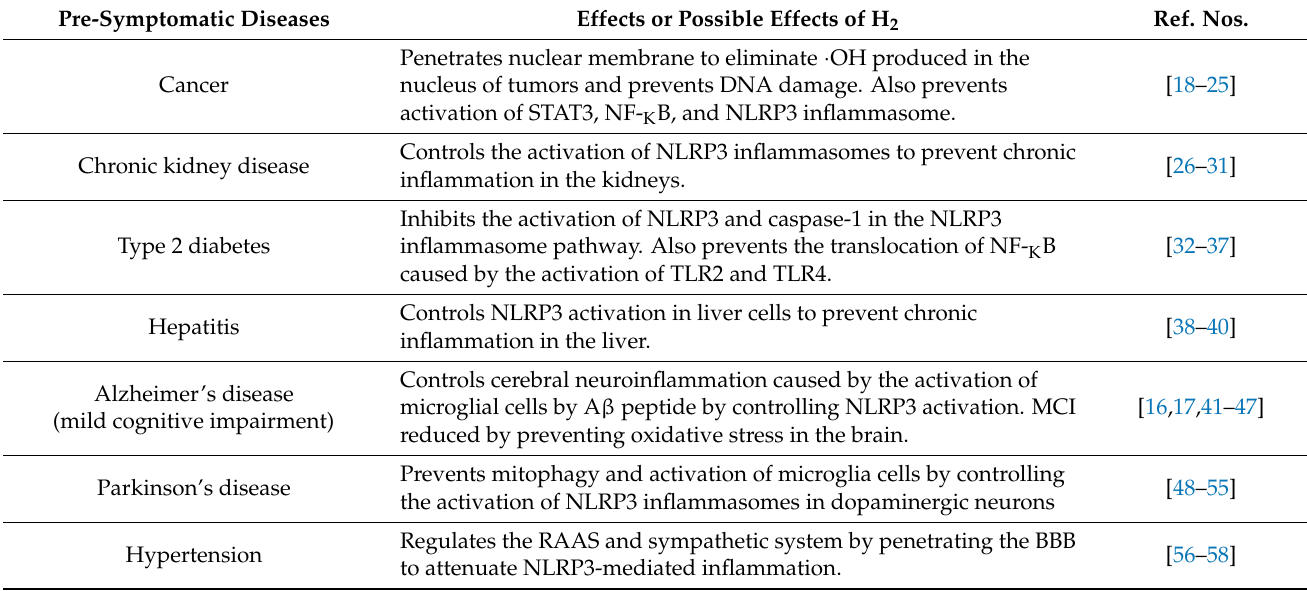
Table 1. Mechanisms of H 2 in preventing inflammatory diseases that arise from mibyou and chronic inflammation. Pre-Symptomatic Diseases Effects or Possible Effects of H 2 Ref.